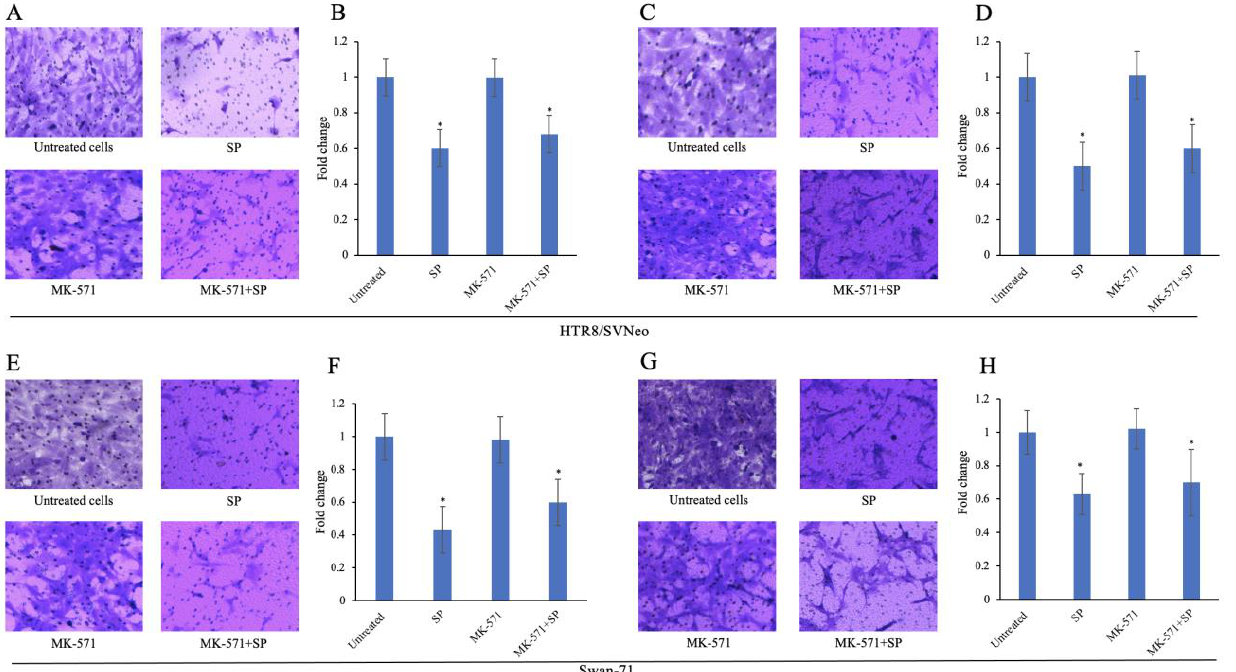
Figure 5. Effect of MK-571 on migration and invasion in palmitic acid-treated HTR-8/SVneo and Swan-71 cells. Migration ( A ) and invasion ( C ) in HTR-8/SVneo cells with or without palmitic acid exposure and MK-571 pretreatment and migration ( E ) and invasion ( G ) of Swan-71 cells after the same exposures. Images were captured from the underside of the transwell inserts. Quantification ( B , D , F , H ) was carried out by counting the migrated or invaded cells using a hemocytometer. Mean values were obtained from three independent experiments and error bars represent SD. * p < 0.05 compared to controls.